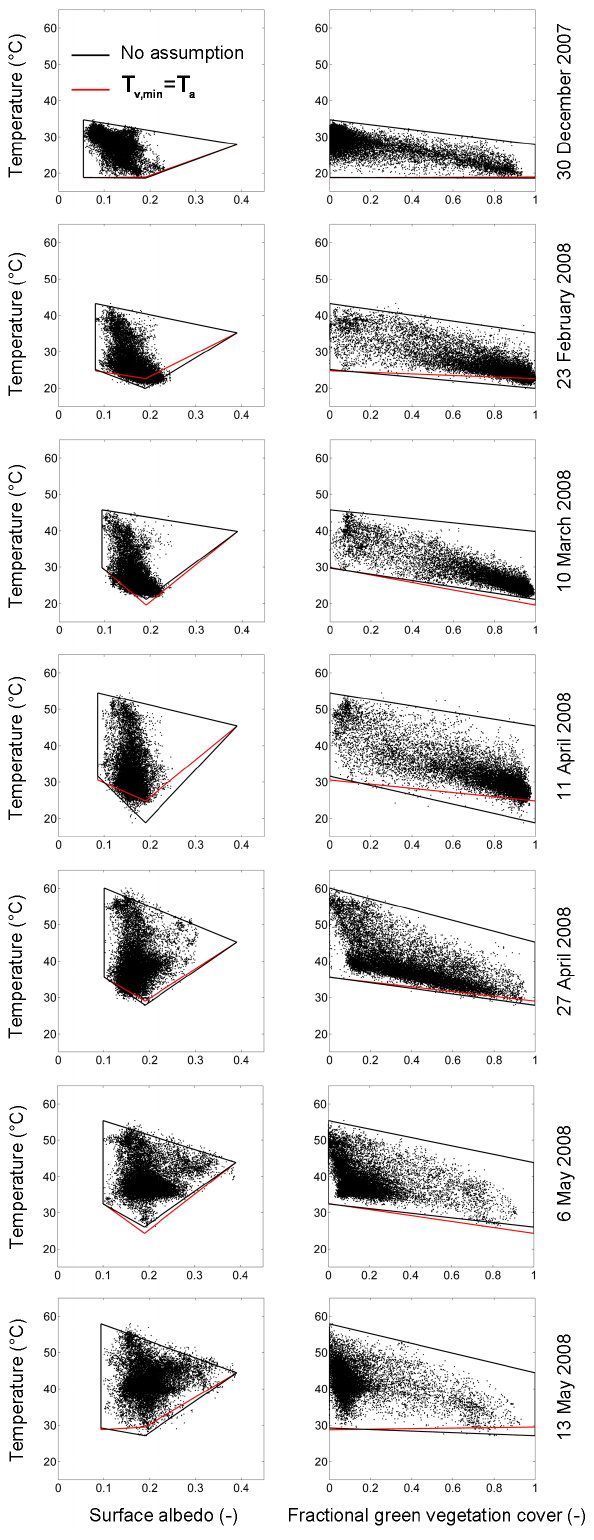
Fig. 4. For each ASTER overpass date, the T − α and T − f vg spaces are overlaid with the polygon built from T v,min = T min (black) and the polygon built from T v,min = T a (red).